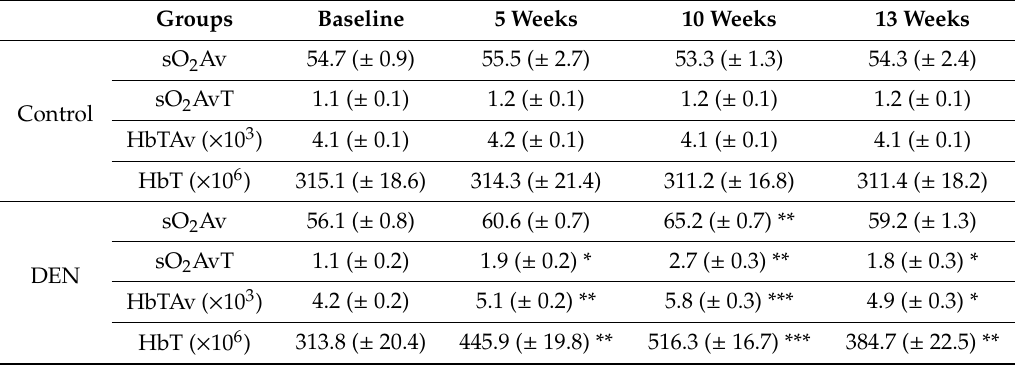
Table 1. Values of oxygen saturation (average = sO 2 Av and average total = sO 2 AvT) and hemoglobin concentration (average = HbTAv and average total = HbT) obtained prior to the start of DEN consumption (baseline) and 5, 10, and 13 weeks after DEN administration. Control rats did not receive DEN.